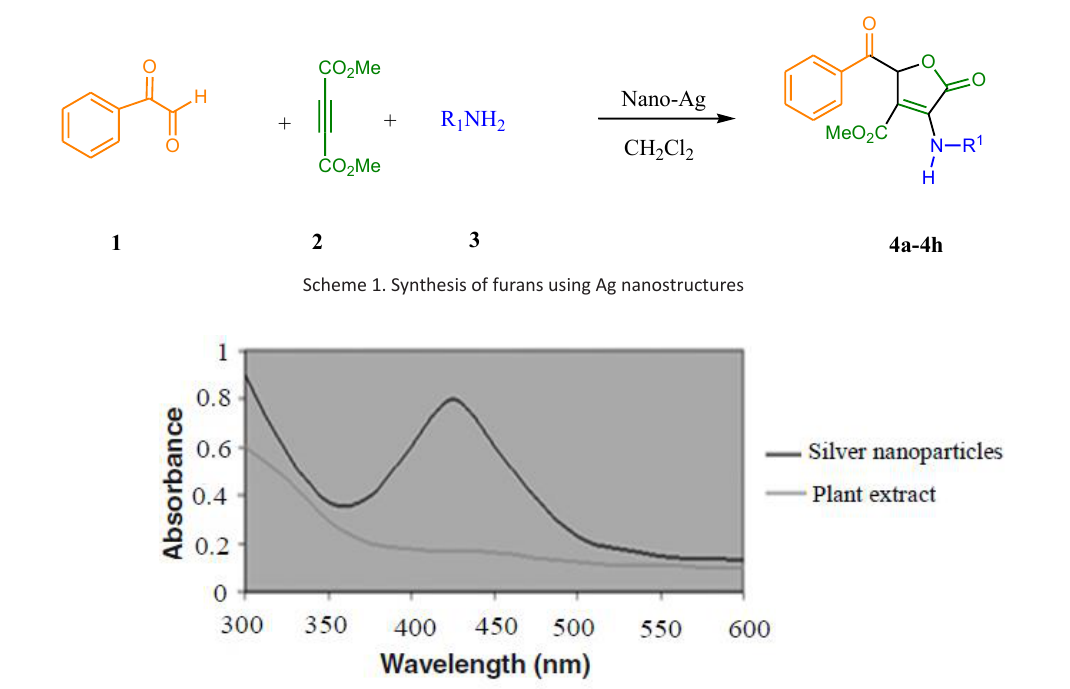
Fig. 1. UV-VIS of Ag nanostructures and plant extract